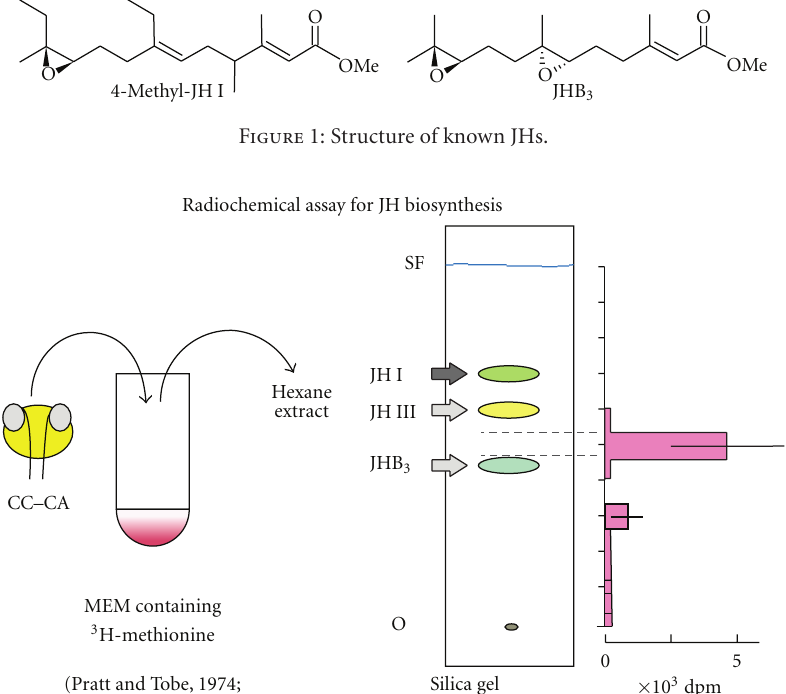
Figure 2: Radiochemical assay for JH biosynthesis. Incubation of CA from Plautia stali adults in a medium containing radiolabeled methionine revealed the presence of an unknown product with an R f value di ff erent from those of JH I, JH III, or JHB 3 in TLC analysis.